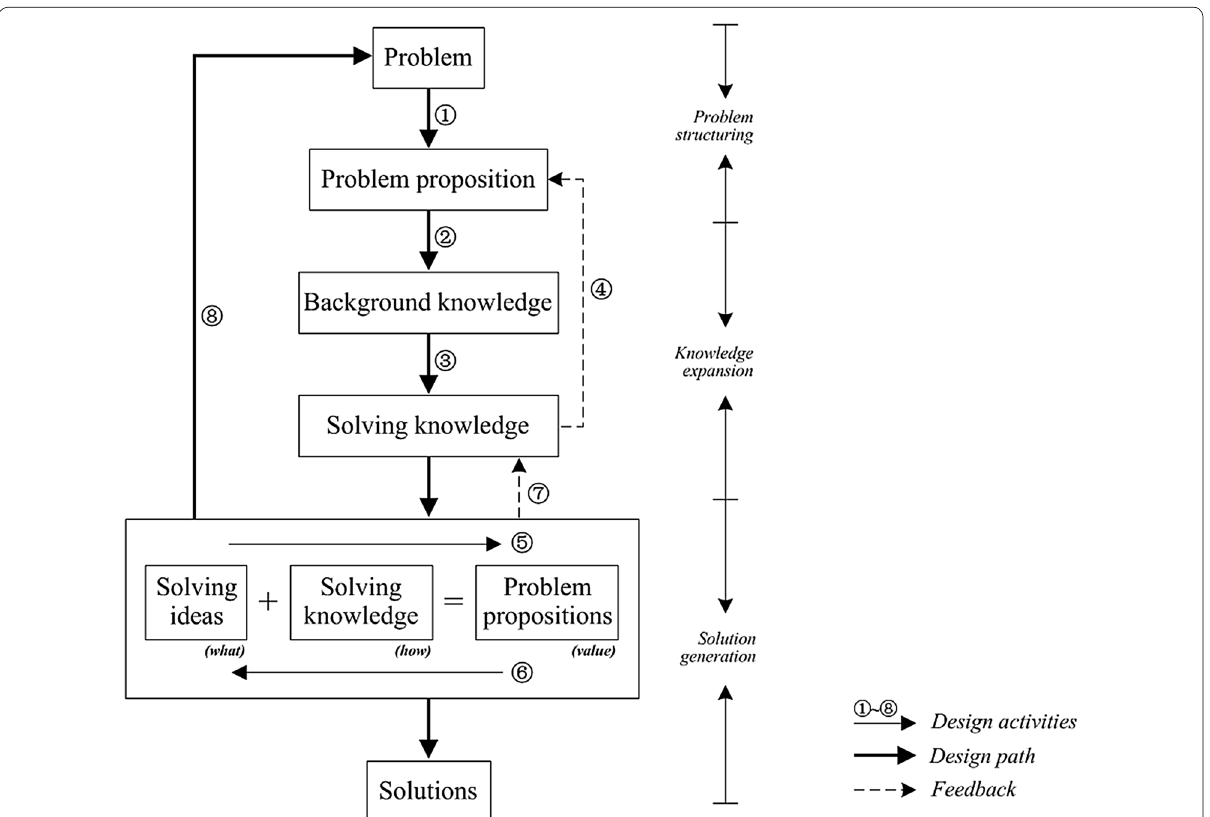
Figure 9 Triple-helix structured model for product innovative